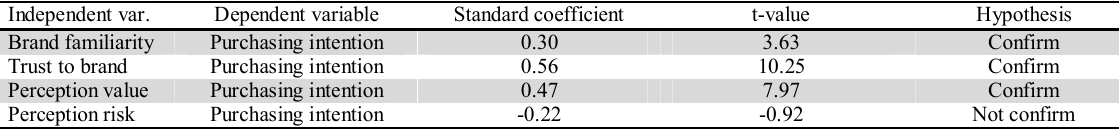
The summary of SEM implementation Independent